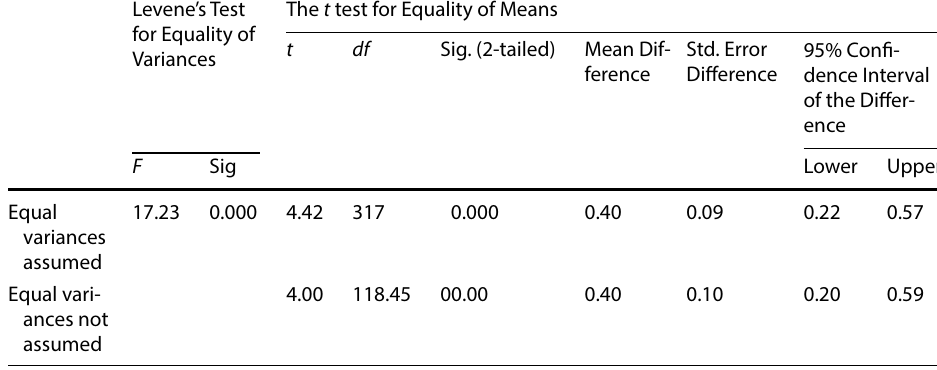
Table 7 t-test for Independent Samples